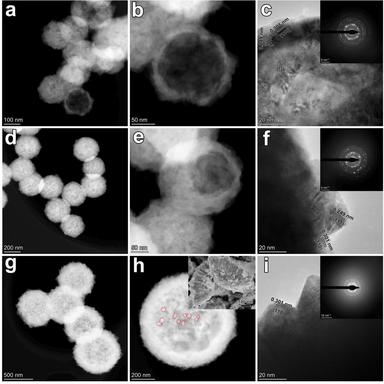
TEM and HRTEM images of (a-c) Cu2O-HNs1, (d-f) Cu2O-HNs2 and (g-i) Cu2O-HNs3.